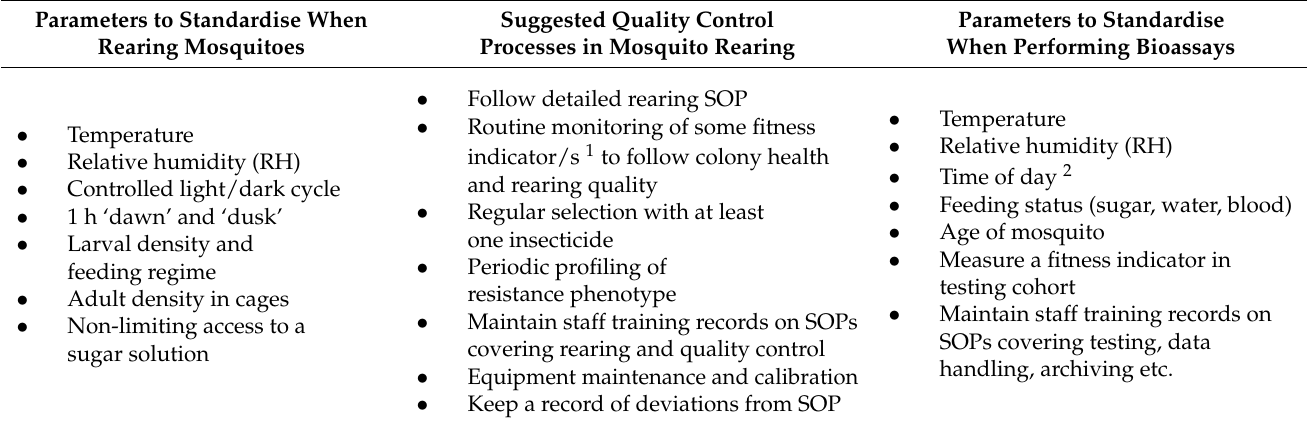
Table 2. Some key considerations for maintaining consistent quality of mosquitoes being reared for bioassays and conditions during bioassays, and steps that can be taken to monitor quality of mosquitoes.